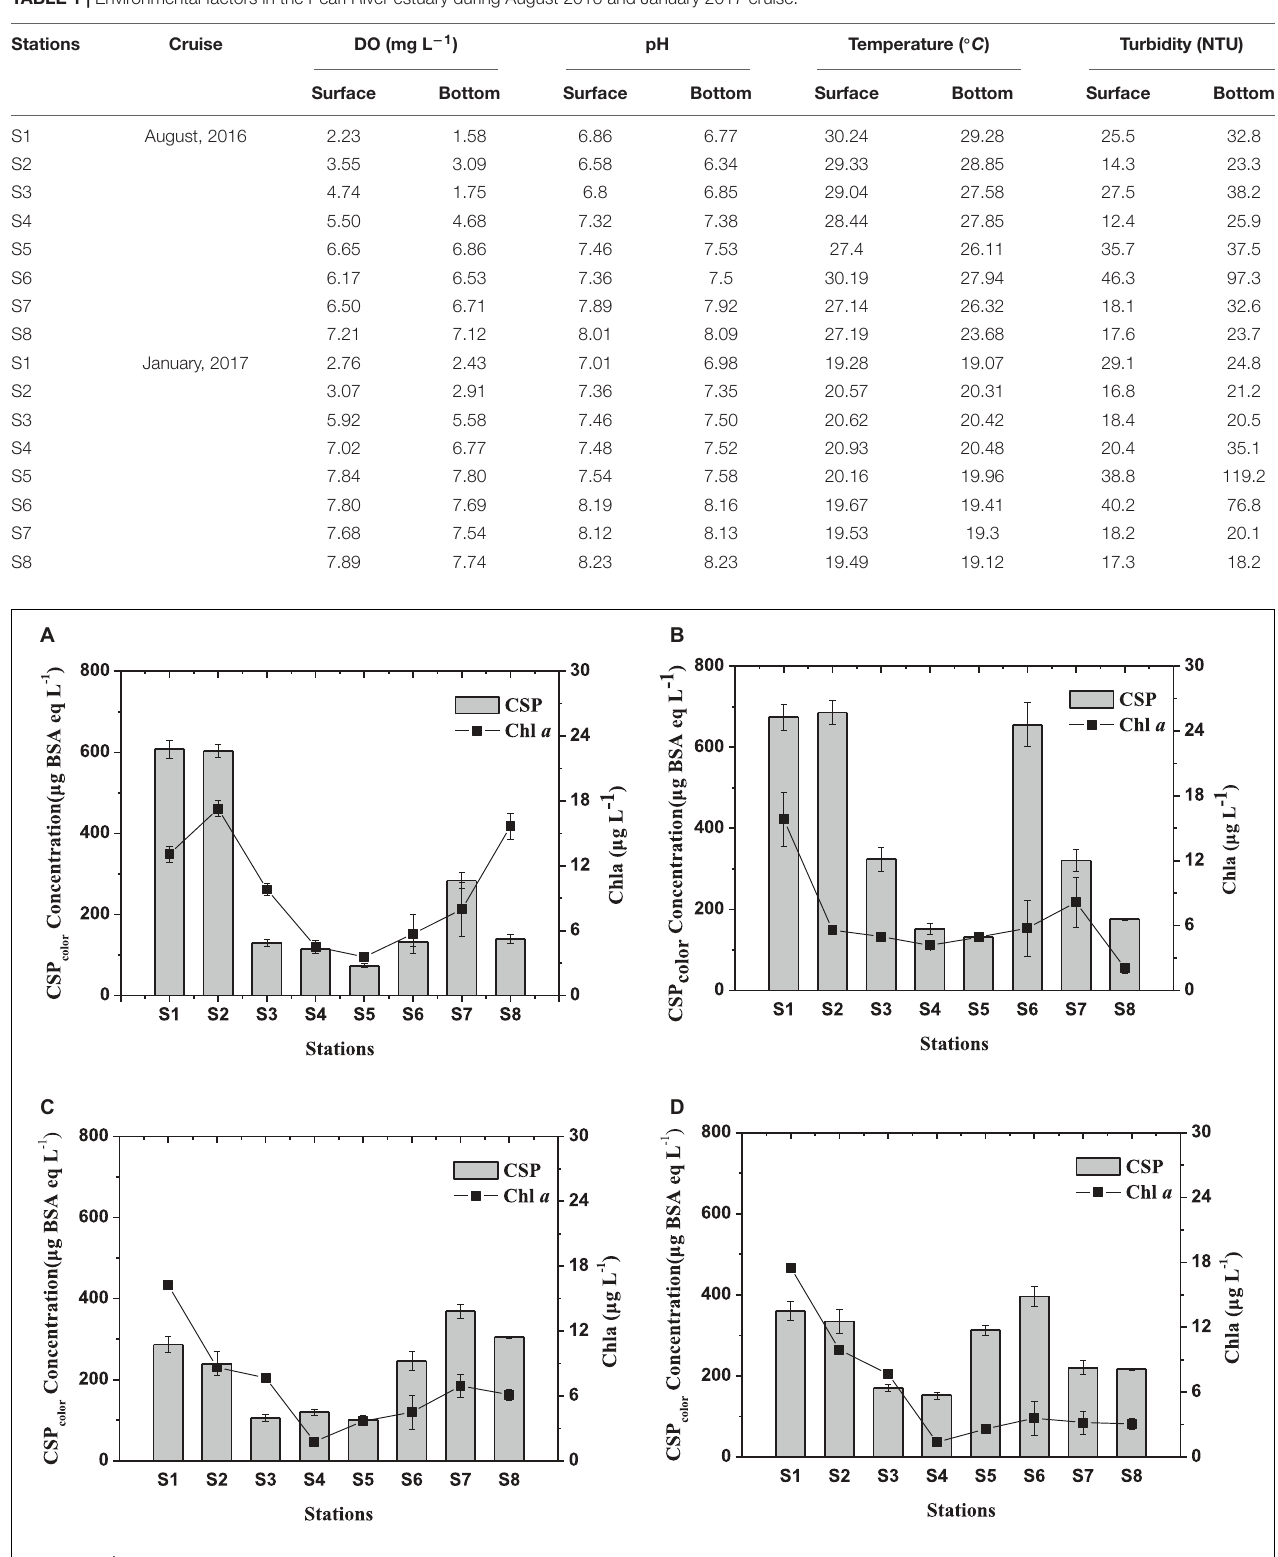
FIGURE 3 | Spatial variations of Chl a and of CSP color concentration in the Pearl River estuary in August 2016 [ (A) surface and (B) bottom] and January 2017 [ (C) surface and (D) bottom].